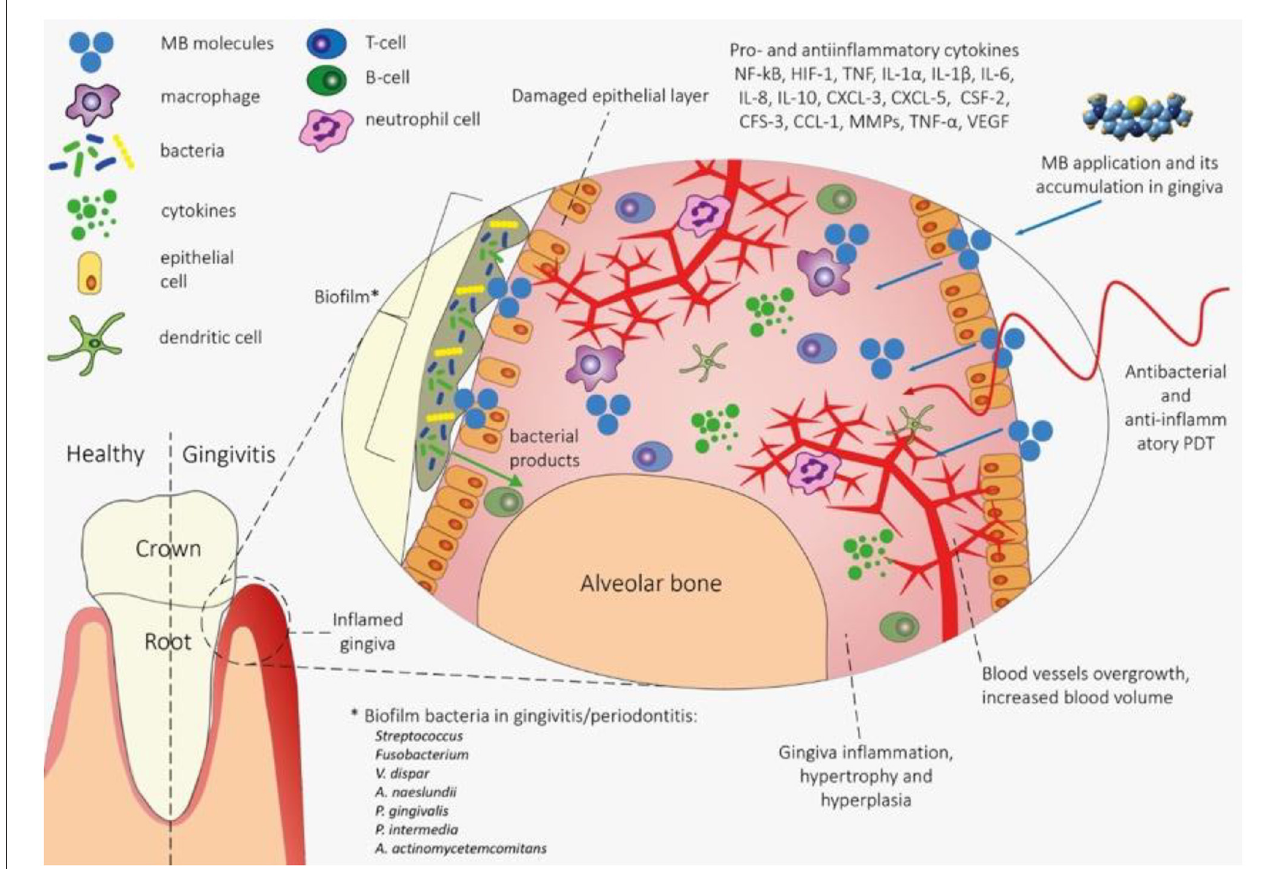
FIGURE1 The mechanism of PDT effects on gingiva tissue in gingivitis. The waste products of biofilm bacteria lead to functional disruption and death of epithelial cells, which contributes to the onset of the inflammatory process triggered by immunocompetent cells (macrophages, neutrophils and T cells). There is increased blood flow, decreased hemoglobin oxygenation and gingiva hyperplasia. When MS is applied to gingival tissue, bacteria and gingival tissue cells are sensitized with a photosensitizer (primarily phagocytes). With the help of photodynamic action, bacteria are eliminated in the biofilm and pro-inflammatory macrophages are deactivated, which leads to a decrease in inflammation and normalization of blood flow and the degree of hemoglobin oxygenation. Methylene blue (MB) is of greatest interest as a PS for anti-inflammatory PDT in order to increase the degree of hemoglobin oxygenation in the microvasculature of periodontal tissues. Initially, methylene blue was the first stain used in medicine as an antiseptic and the first photosensitizer tested and approved for use for antimicrobial photodynamic therapy